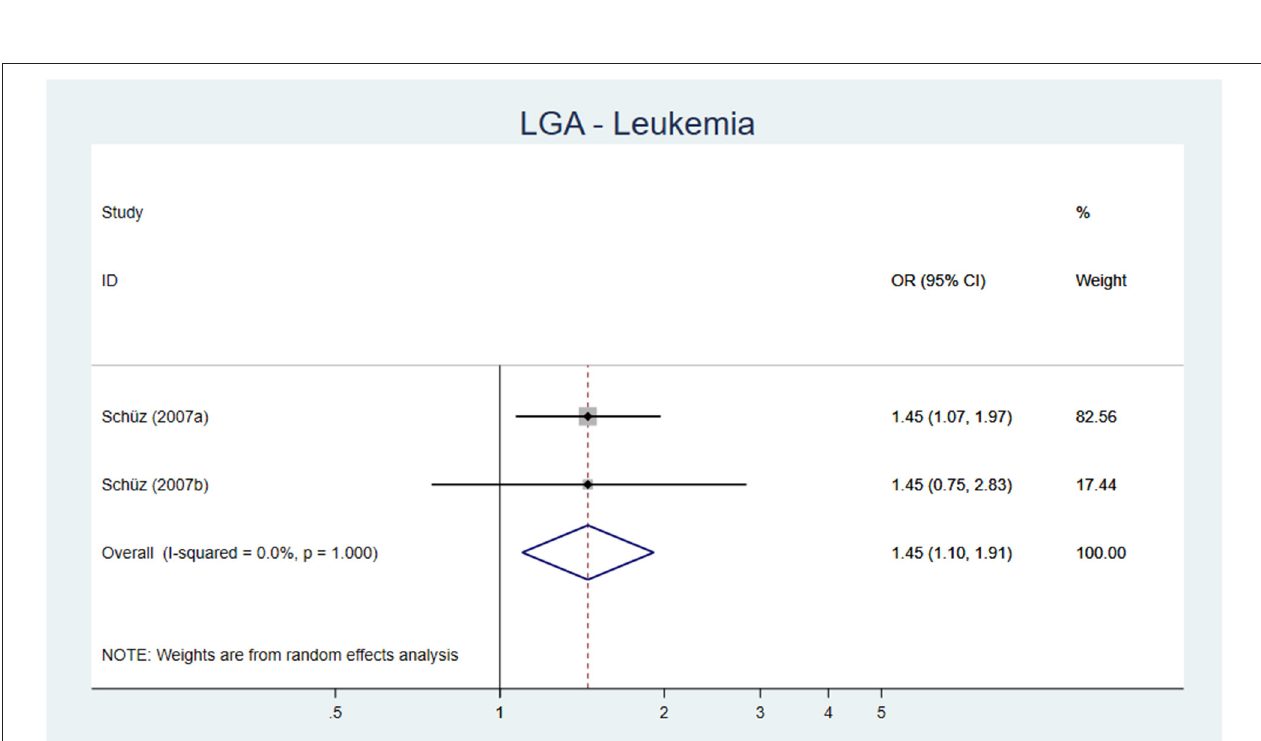
FIGURE 5 | Forest plot describing the association between high birth weight and leukemia.